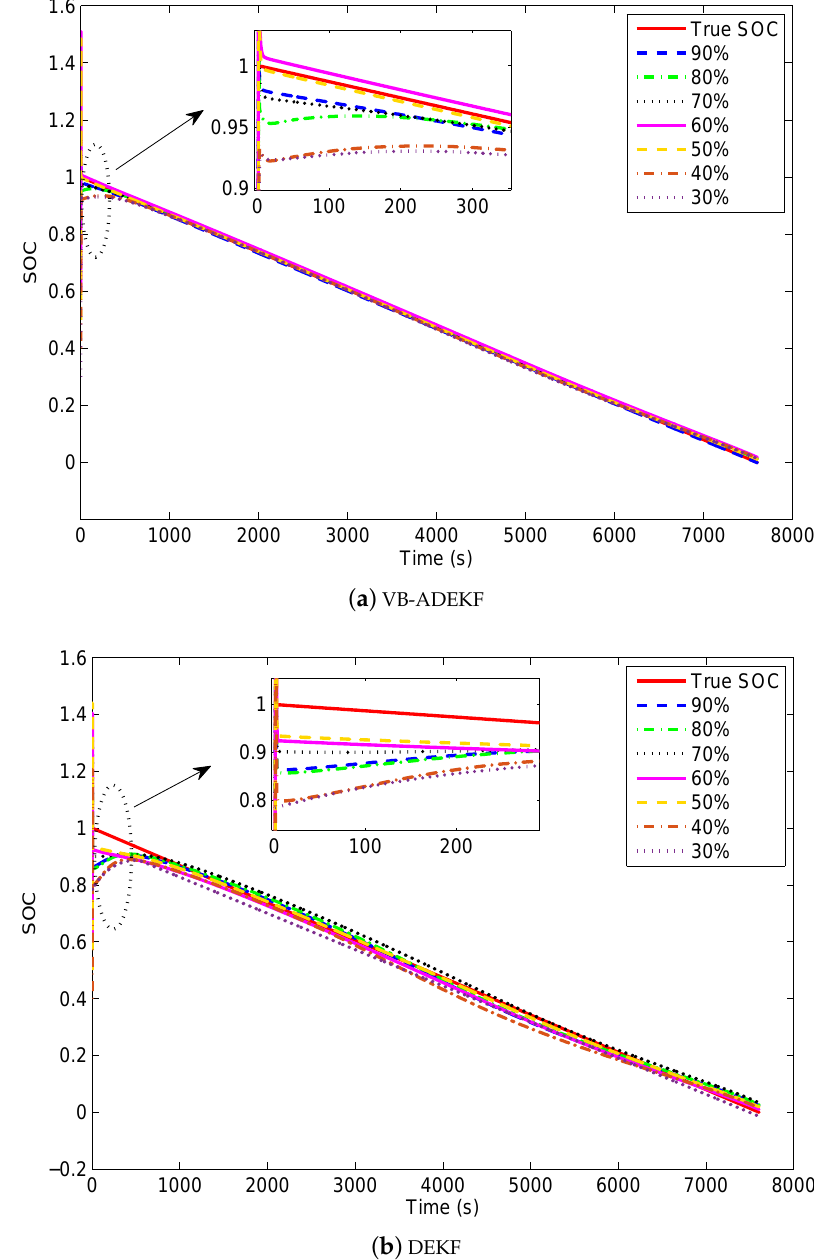
Figure 14. SOC estimation results of the two filters with different initial SOC values in the constant current discharge